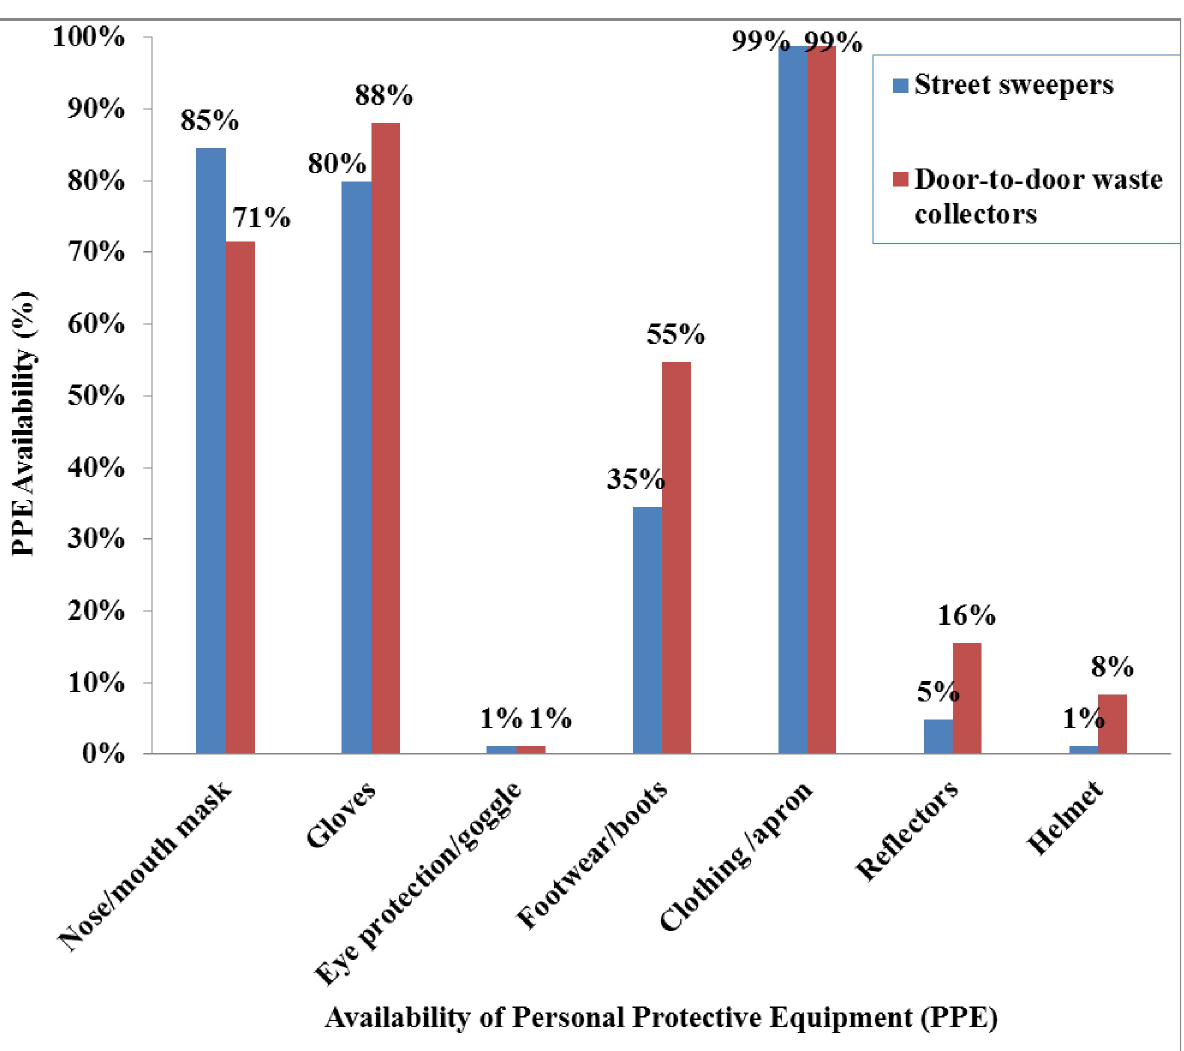
Fig 3. Availability of personal protective equipment among street sweepers and door-to-door waste collectors in Dessie City, Ethiopia, March to May 2018.